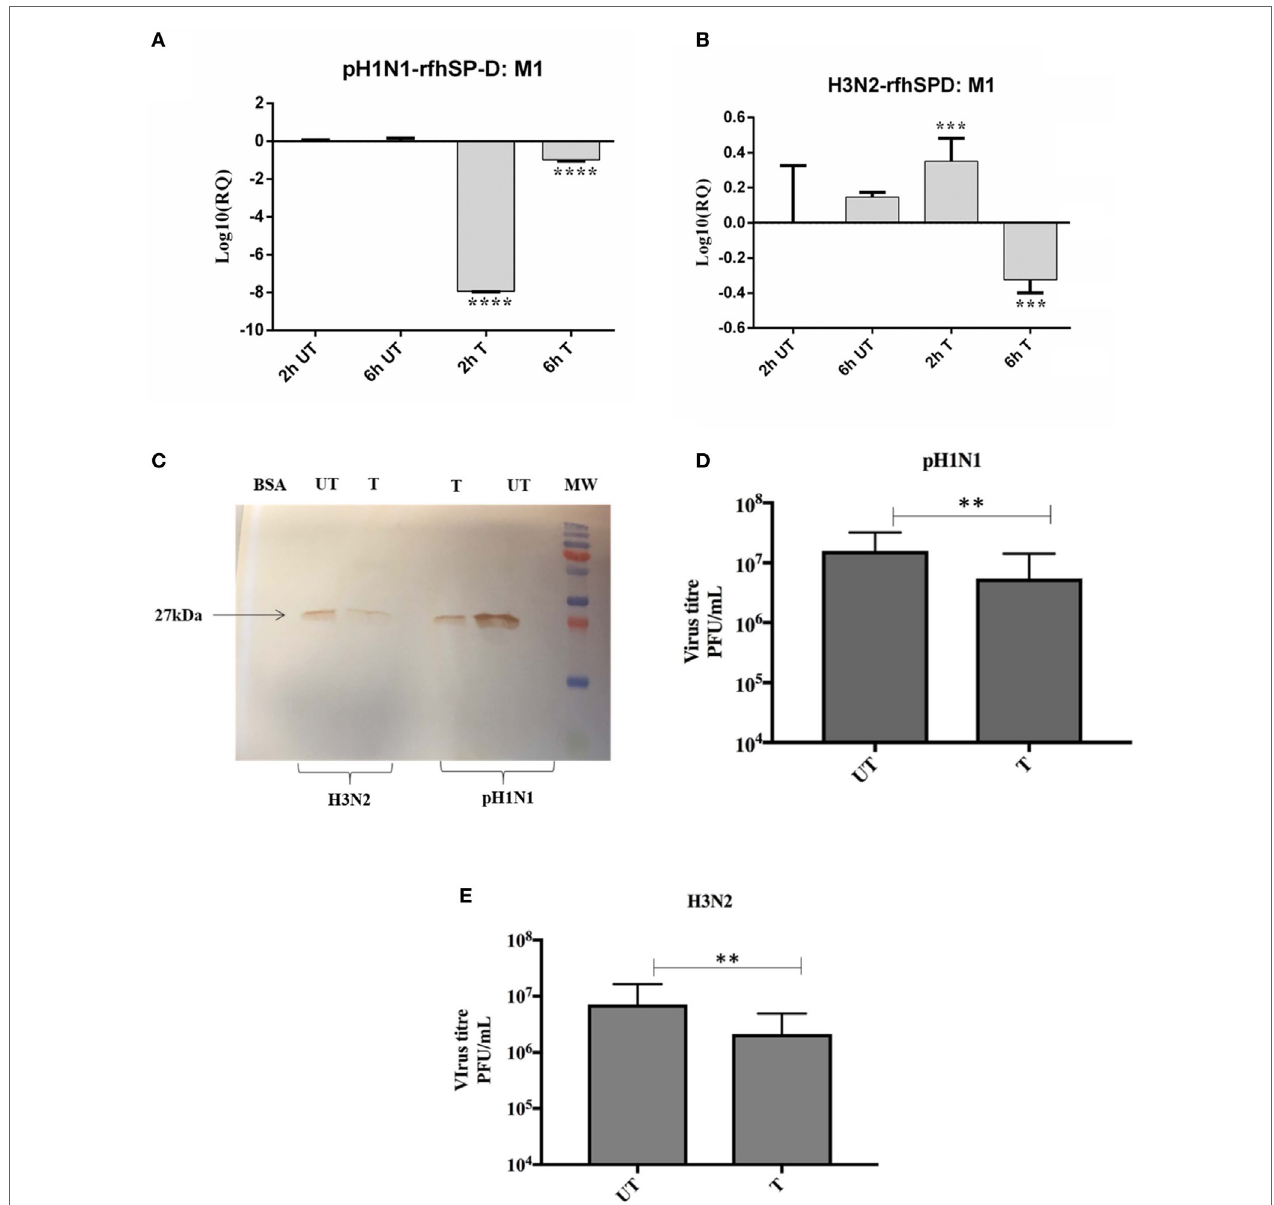
FigUre 5 | rfhSP-D restricts replication of (a) pH1N1 and (B) H3N2 in target human A549 cells. M1 expression of both pH1N1 and H3N2 influenza A virus (IAV) (MOI 1) after infection of A549 cells at differential time points at 2 and 6 h. A549 cells were incubated either with pre-incubated pH1N1 and H3N2 with (10 µg) or without purified rfhSP-D. Cell pellets were harvested at 2 and 6 h to analyze the M1 expression of IAV. Cells were lysed, and purified RNA extracted was converted into cDNA. Infection was measured via qRT-PCR using M1 primers and 18S was used as an endogenous control. Results shown are normalized to M1 levels at 2 h untreated. Significance was determined using the unpaired one-way ANOVA test (** p < 0.01, *** p < 0.001, and **** p < 0.0001) ( n = 3). (c) Western blotting to shown M1 expression in both untreated (cells + virus) and treated (cells + virus + 10 µg/ml rfhSP-D) following 6 h incubation. Titration assay to show the anti-IAV activity of rfhSP-D (10 µg/ml), using both pH1N1 (D) and H3N2 (e) subtypes. A549 cells were infected with pH1N1/H3N2 (MOI 1) for 24 h. Then, the supernatants were collected and virus titers measured using a TCID50 assay. Treatment with rfhSP-D reduced viral titers by approximately 40%, suggesting that rfhSP-D acts as an entry